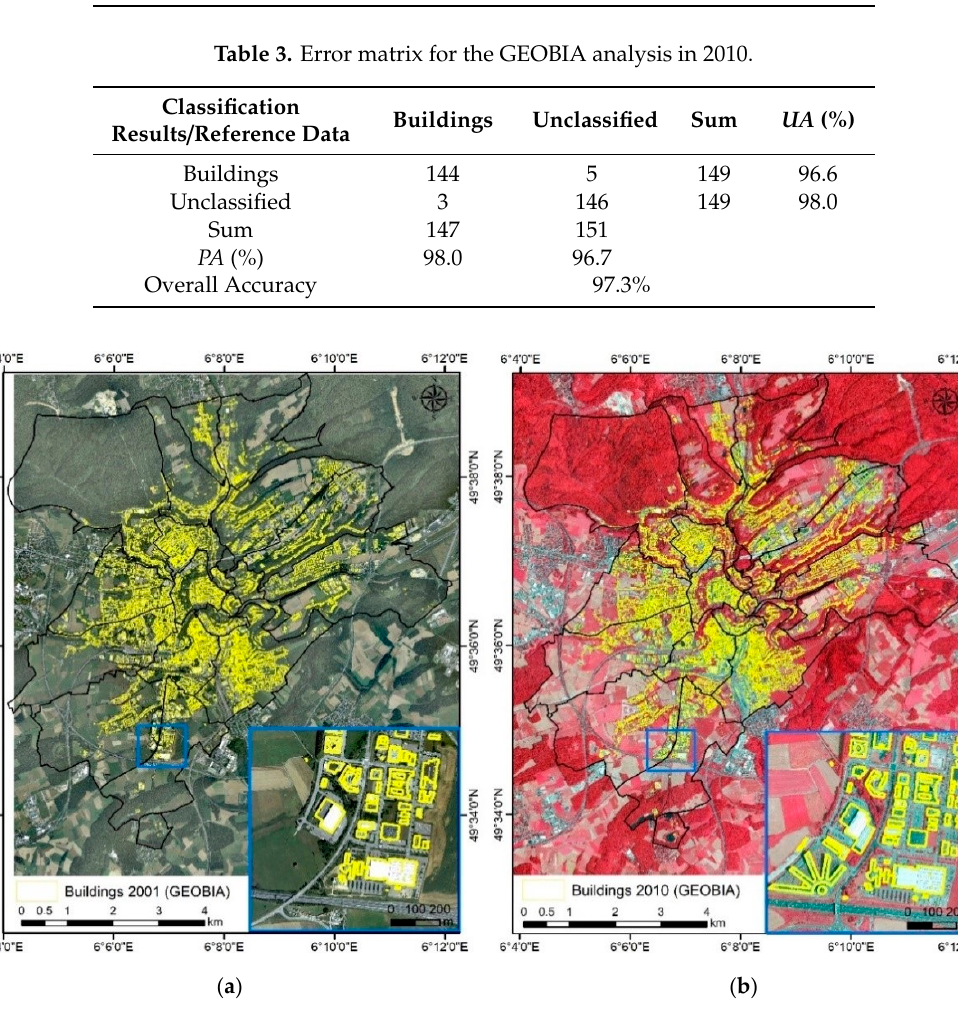
Figure 7. GEOBIA classification of buildings based on ( a ) RGB aerial orthophoto maps in 2001 and ( b ) CIR orthophoto maps in 2010.